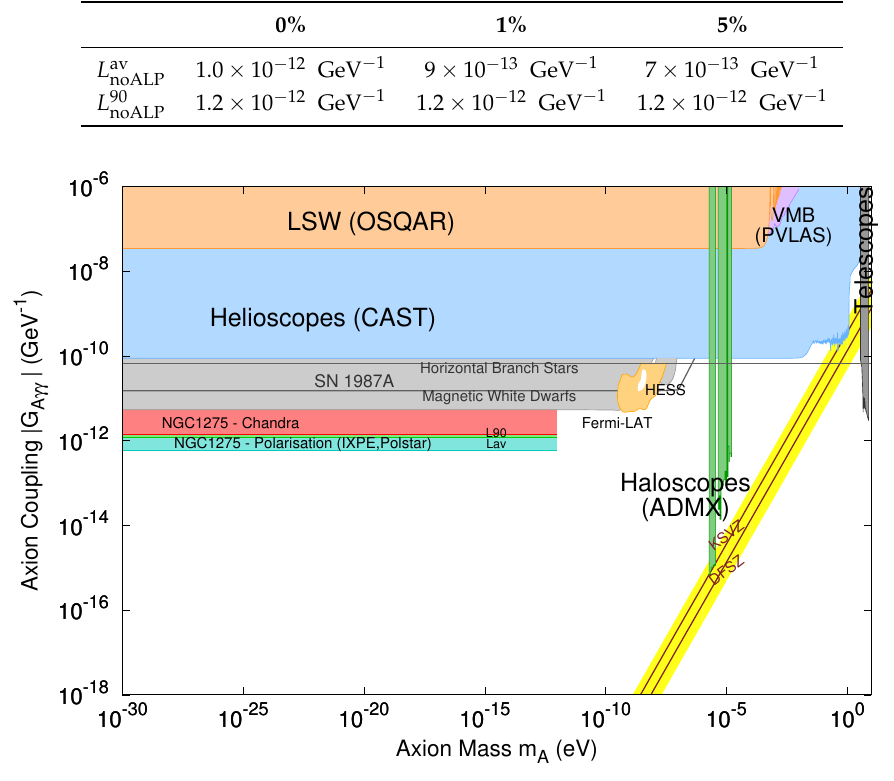
Figure 2. Projected bounds on the ALP-photon coupling assuming a 5% initial polarization. Adapted from [3]. We also include bounds set in [41]. These are based on the non-observation of high degrees of linear polarization in magnetic white dwarfs, using simplified models of the strong magnetic fields these